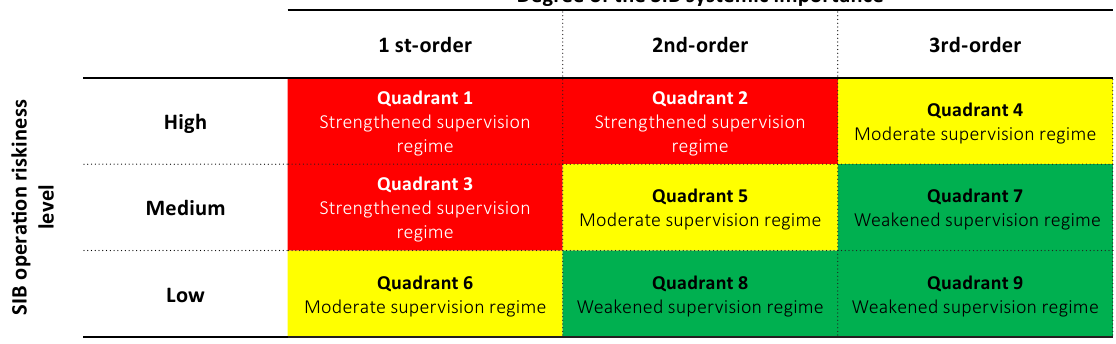
Figure 1. Matrix of the selected supervision regime types for systemically important banks